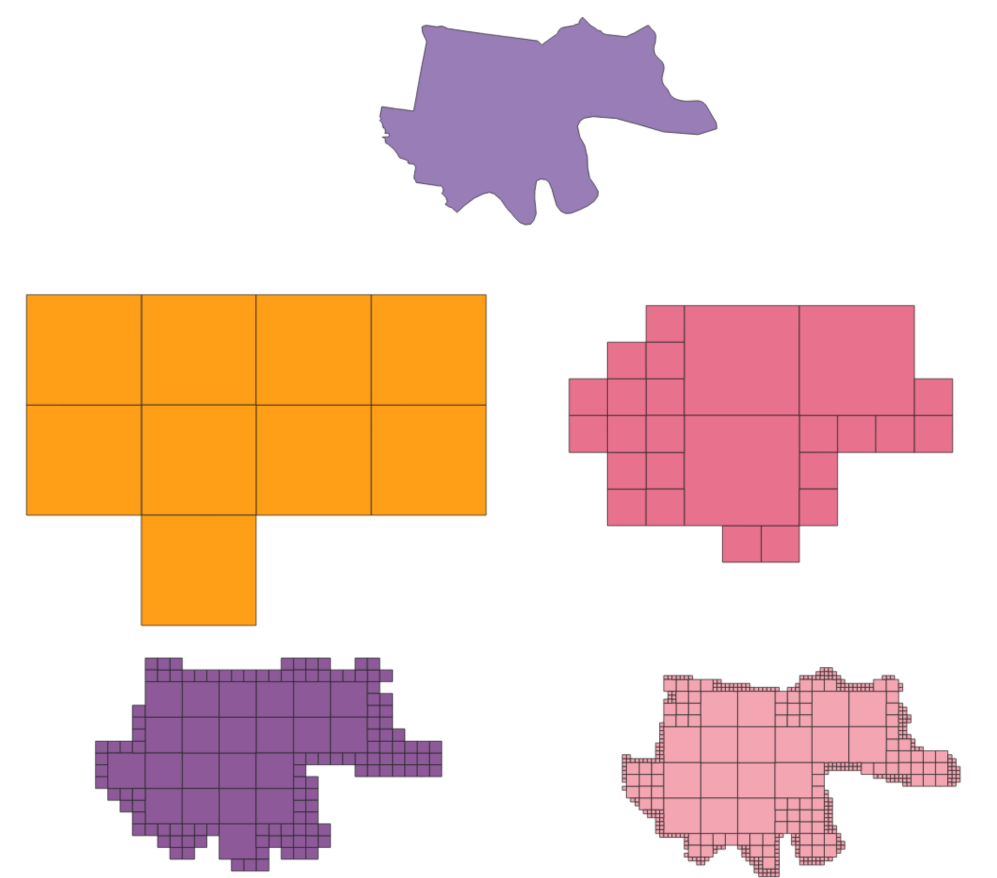
Figure 5. AusPIX Discrete Global Grid System representations of the Brisbane electoral district area geometry. The original polygon is represented at the top with the four lower images showing AusPIX DGGS cells at higher and higher resolutions, so-called levels 7, 8, 9 and